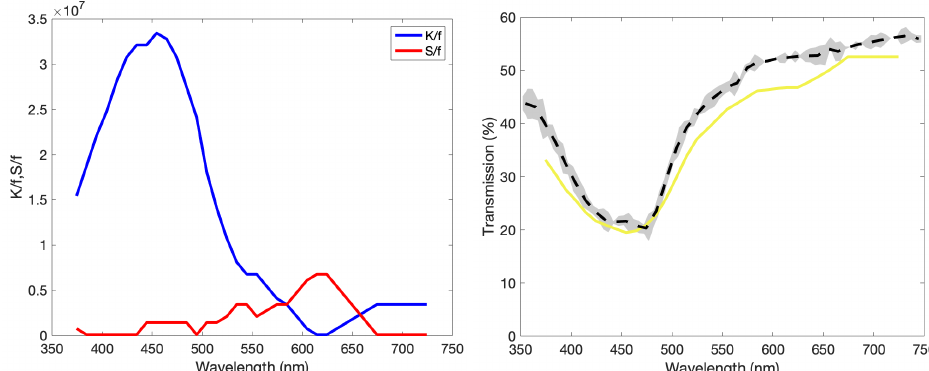
Figure 11. K / f and S / f values, varying with wavelength, chosen to match the transmittance of each spectra. Alongside these are the measured (dashed) and predicted (solid) transmittance for cyan (top), magenta (middle) and yellow (bottom). Also shown is the standard deviation of the measured transmittance. Here, we have scaled by the volume fraction to attempt to make the fit more general.